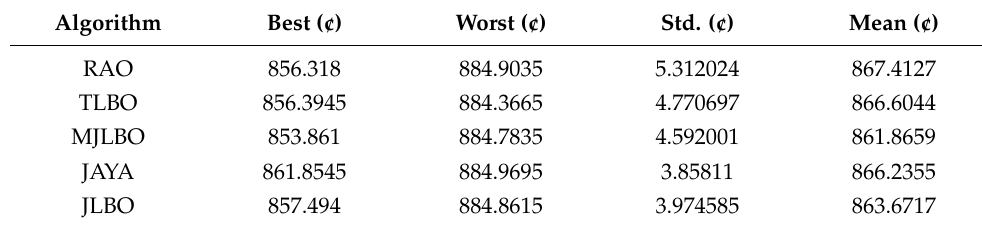
Table 6. Fitness function comparison for 1500 iterations.